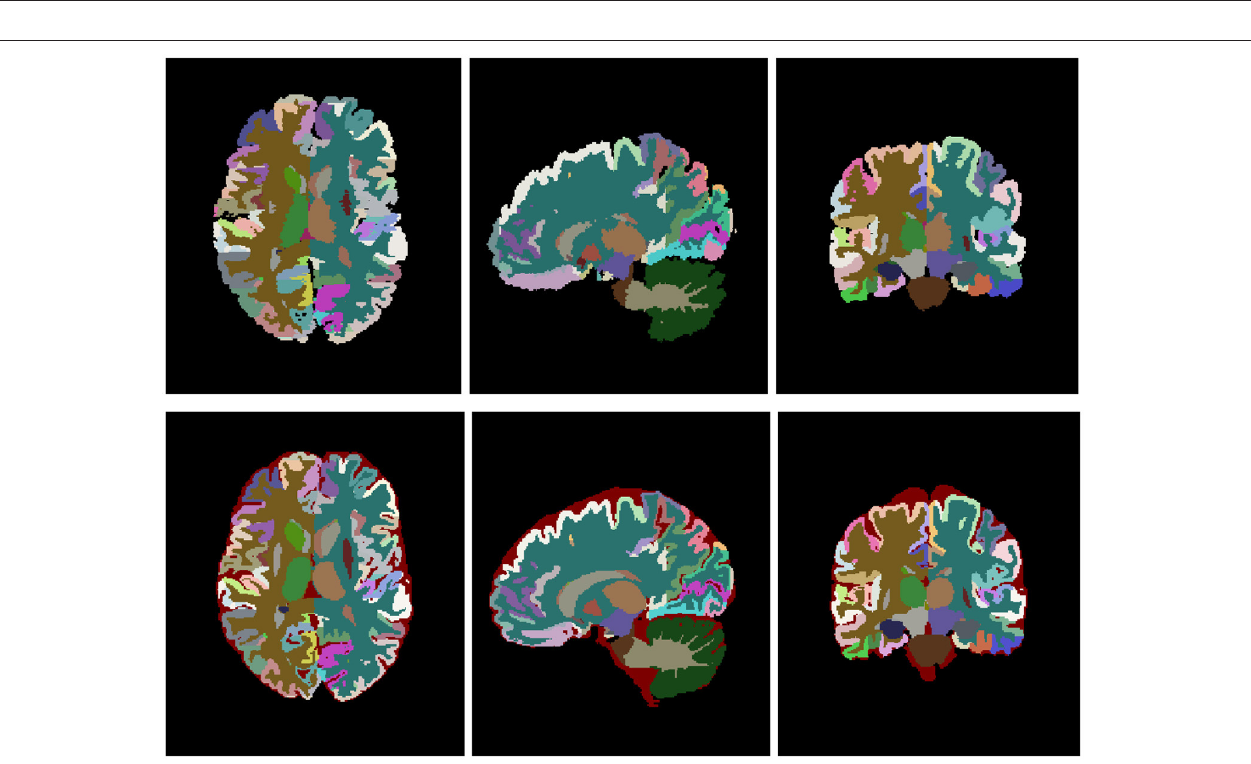
FIGURE 2 | Top row shows the original labeling and bottom row shows the corrected labeling. Note that the external CSF label has been added to the labeling